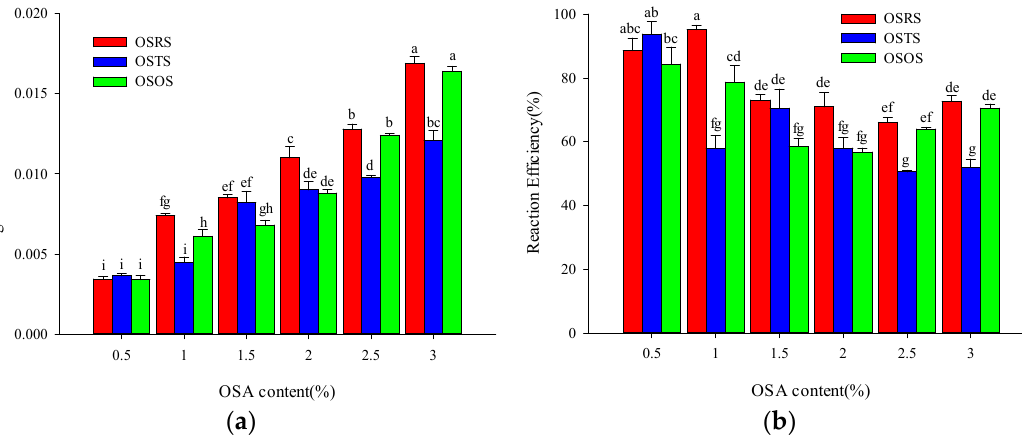
Figure 2. DS ( a ) and RE ( b ) values of OS-starch. The data means average value ( n = 3); the different letters (a–i) means differ significantly ( p < 0.05), the same indicates that the difference is not significant ( p > 0.05).